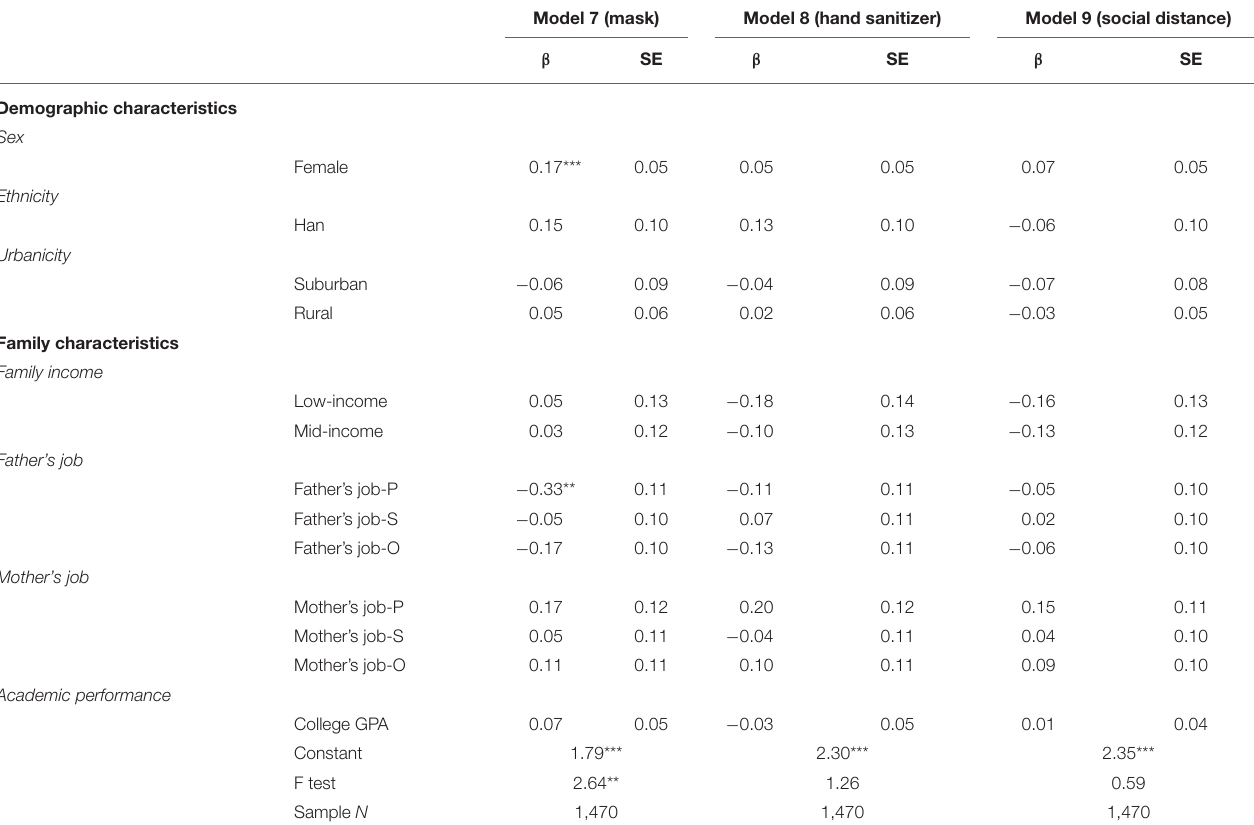
TABLE 5 | The relationships between family characteristics and students’ preparedness for